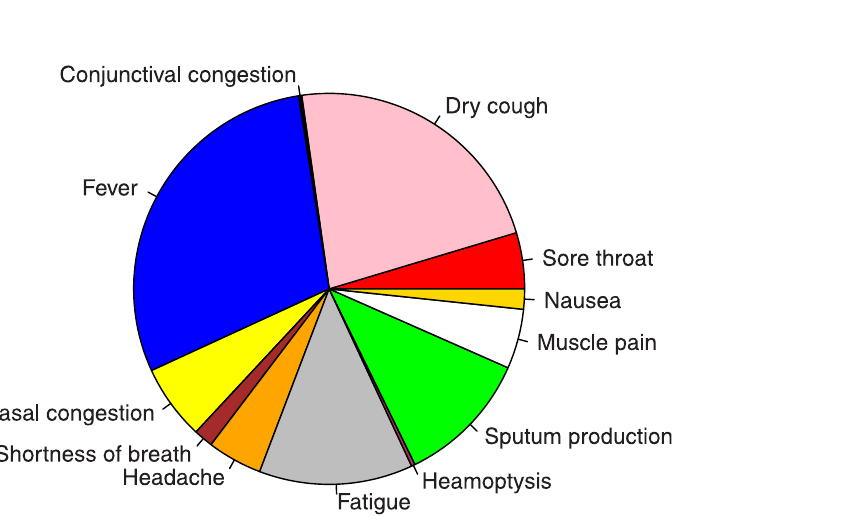
Fig 1. Graphical display for the percentage of the symptoms of